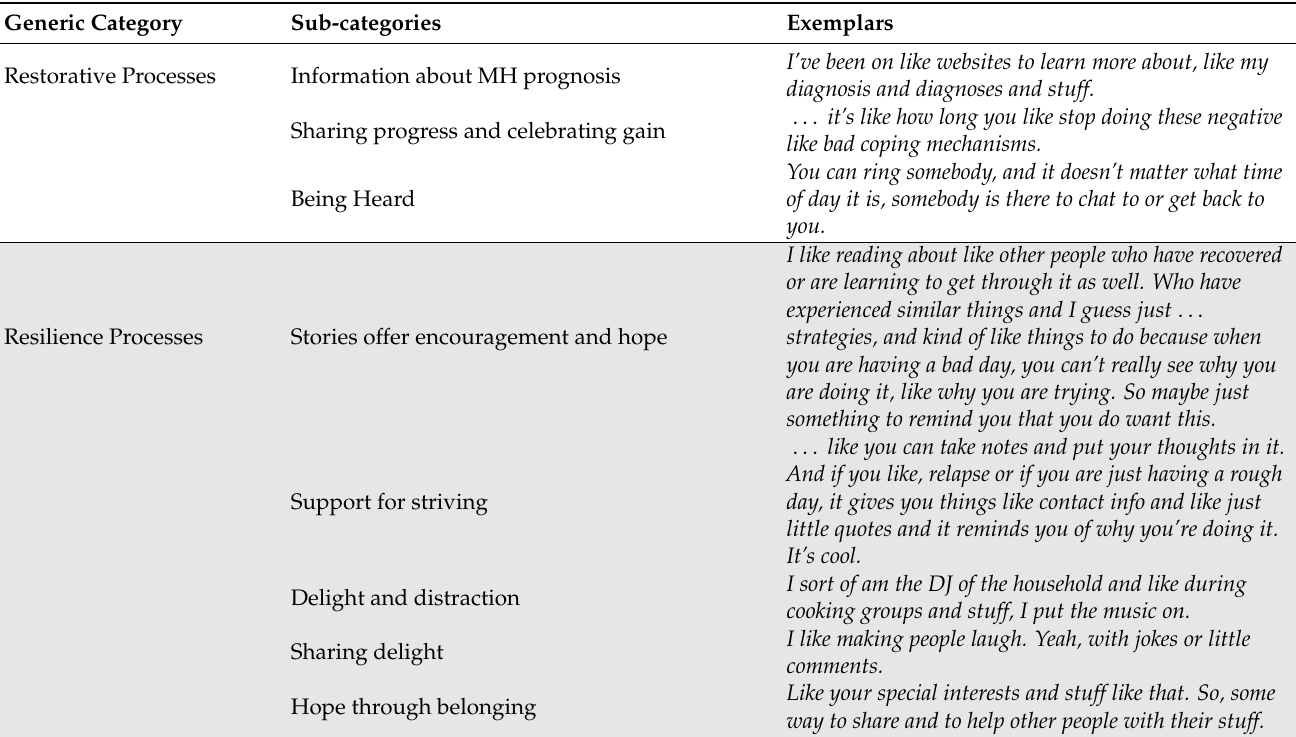
Table 6. Exemplars and categories related to Hope recovery